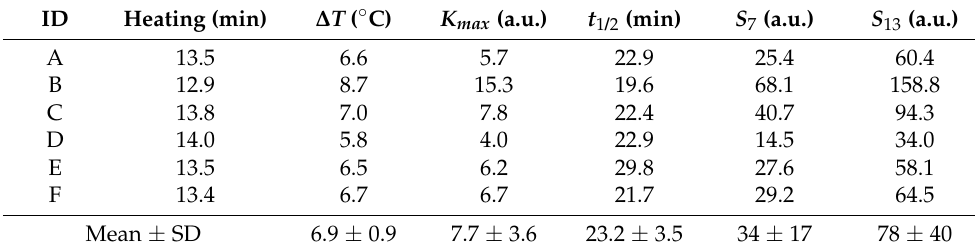
Table 4. Parameters of the perfusion reaction to local skin heating for 19 min. Table 3. Parameters of the perfusion reaction to local skin heating for 13 min.